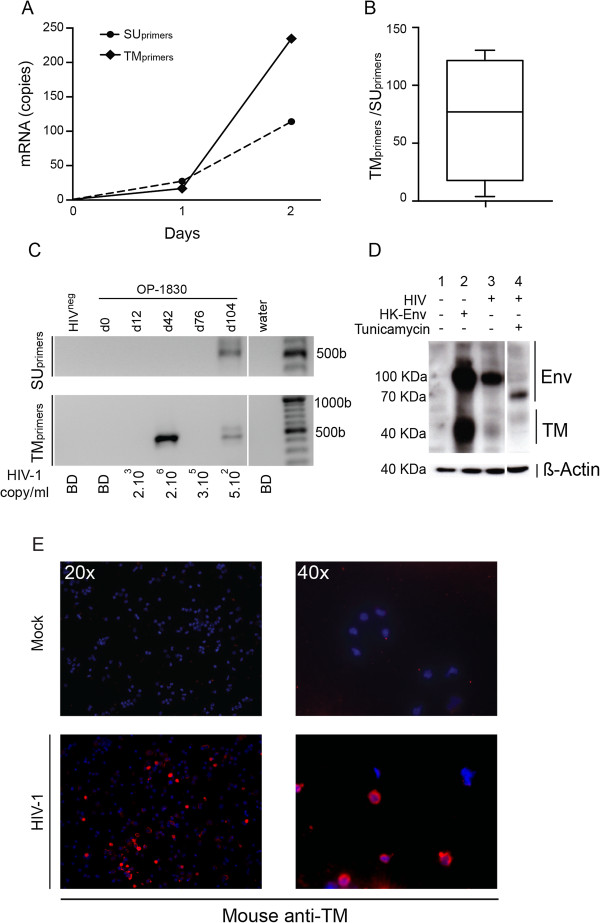
Evidence of trans-activation and post-transcriptional modification of HERV-K (HML-2) Env TM. A) HERV-K (HML-2) Env mRNA expression was detected using primers designed to bind the SU domain or TM domain (SUprimers or TMprimers respectively) at 0,1 and 2 days post infection. Copies of HERV-K (HML-2) Env detected by TMprimers (plain line) increased by the time of infection compared to the copies detected by SUprimers (dashed line). The graph is a representative experiment of 3 individual independent experiments. Copy number was determined as described previously, and β-Actin was used as reference gene [52]. B) The graph represents cumulative data from 3 independent experiments and shows the ratio of copies of HERV-K (HML-2) Env detected by TMprimers/copies detected by SUprimers from HIV-1LAI infected PBMCs 2 days post-infection. Similar data were obtained using primary isolates (91US_4/R5 tropic and BK132/X4 tropic). C) Nested PCR. The figure shows the amplicons obtained after the second round of PCR (around 500pb). TM mRNA is over-expressed during the peak of viremia at d42. Antiviral treatment induced the transcription of both SU and TM mRNA at a similar level. HIVneg: HIV-1 seronegative low risk donor; OP-1830: HIV-1 seroconverter patient (d0: before infection; d12, d42, d76: after infection without treatment, d104: after treatment); water: the non-template well. (D) Assumed precursor proteins at 75 to 90 kDa and TM subunits at 32 to 38 kDa are visible. Hela-T4 cells are infected by HIV-1LAI in presence (4) or not (3) of 10 μl/ml of tunicamycin. HERK-Env transfected cells (2) were used as positive controls for HERV-K TM expression. Uninfected-untransfected cells were used as control for endogenous HERV-K basal expression (1). (E) Representative images of HERV-K TM extracellular expression on PBMCs. HERM-1811-5 (anti-TM) mouse monoclonal antibody and goat anti-mouse Alexa555 (red) were used to detect extracellular expression of HERV-K (HML-2) TM.